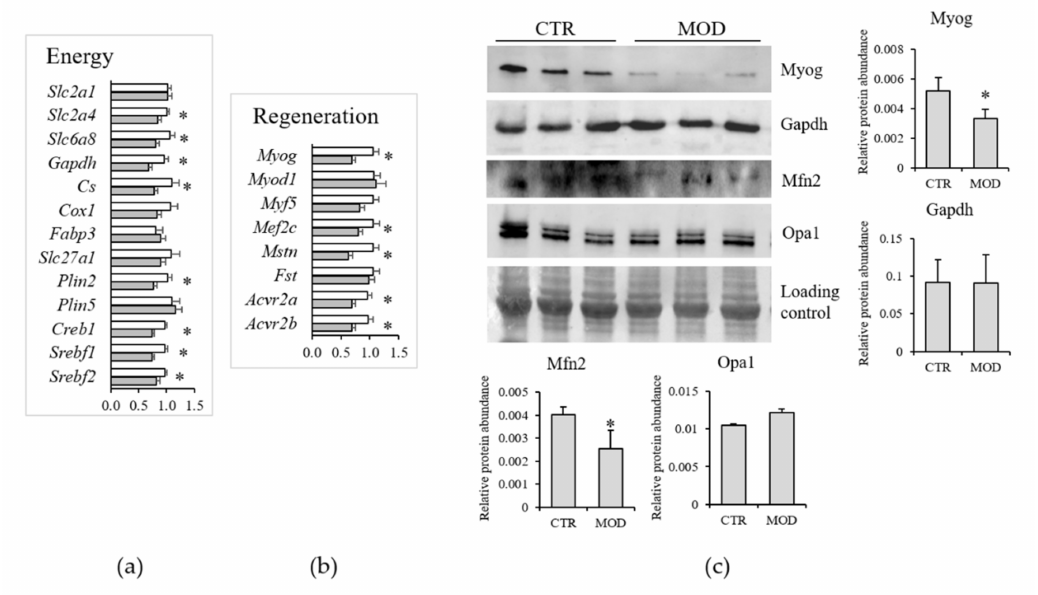
Figure 6. Muscle mRNA levels of genes involved in energy metabolism ( a ) and muscle regeneration ( b ) in mice fed a mildly Mg 2+ -deficient diet. Results are means ± SE ( N = 12). White columns CTR, grey columns mild Mg 2+ deficiency. ( c ) Western blot was performed on 40 µ g of lysates using specific antibodies against Myog, Gapdh, Mfn1, and Opa1. A representative western is shown. Densitometry was performed on three different blots. * indicates significant difference ( P < 0.05) from the CTR